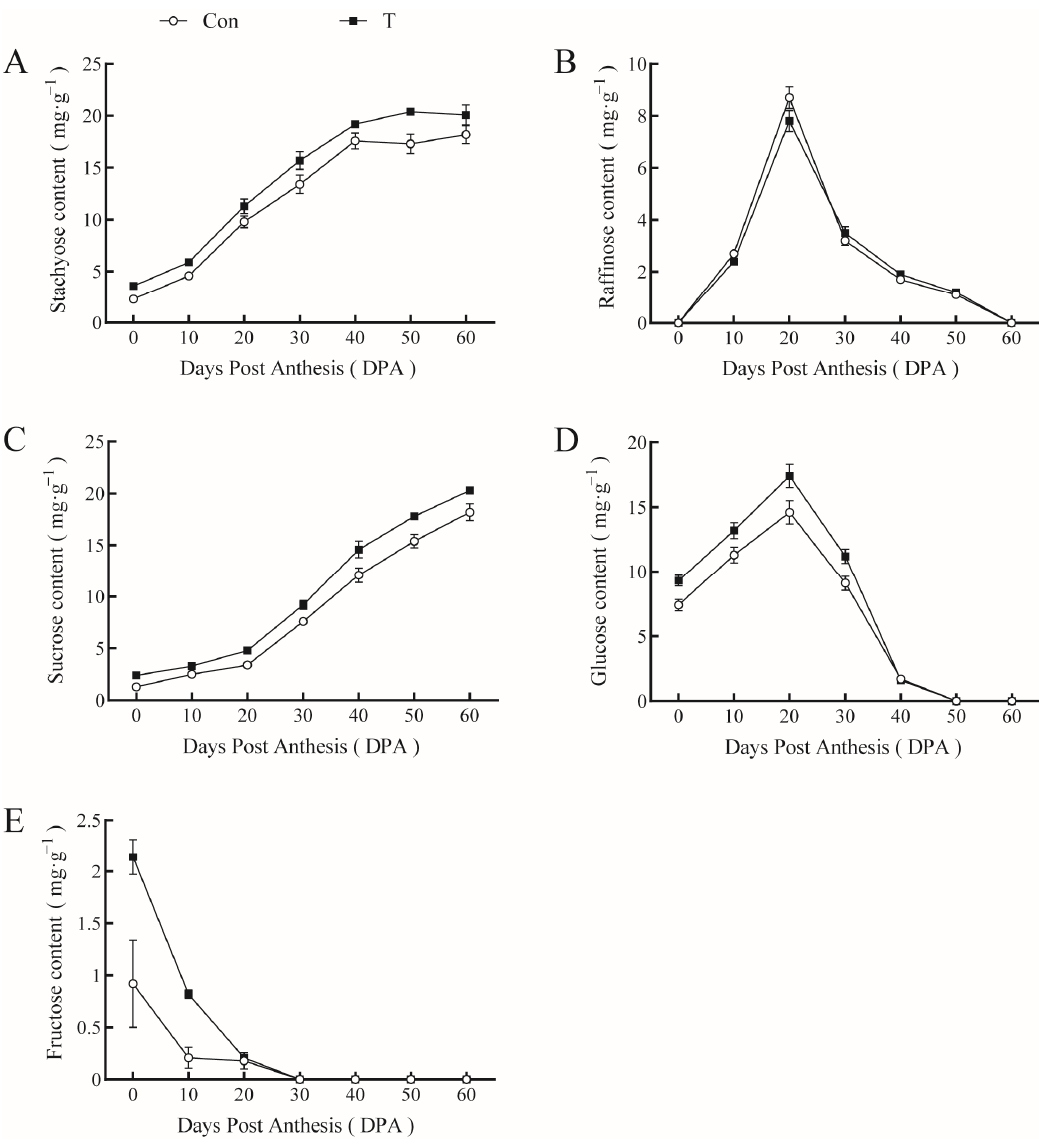
Figure 6. Effect of NAA and EBR on soluble sugar content in the phloem sap of giant pumpkin. ( A ) Stachyose, ( B ) raffinose, ( C ) sucrose, ( D ) glucose, ( E ) fructose.